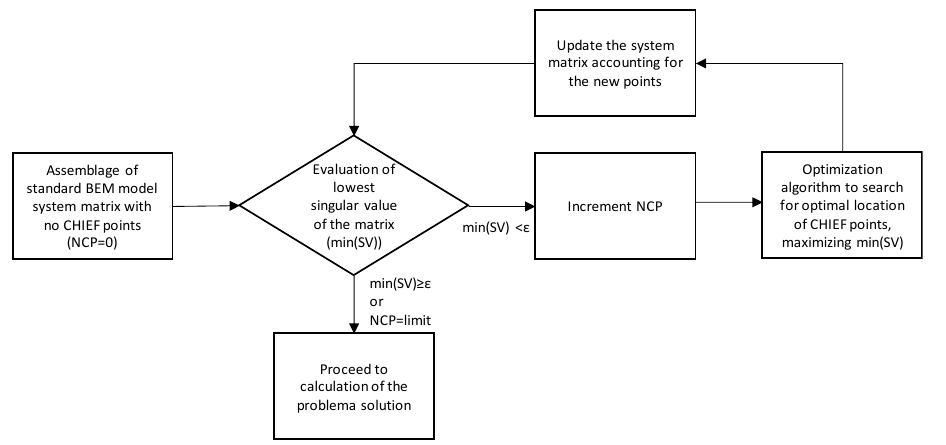
Figure 2. Flowchart of the proposed algorithm.